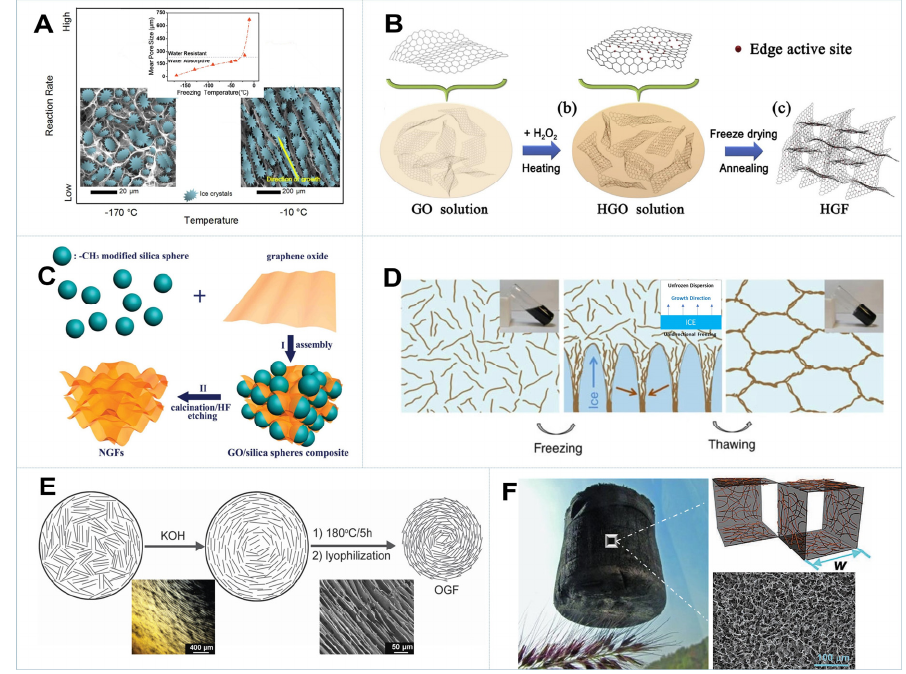
Figure 3. ( A ) The pore size of graphene aerogel as a function of freezing temperature [58]. ( B ) Synthesis procedures of holey graphene framework (HGF) [64]. ( C ) Schematic illustration of